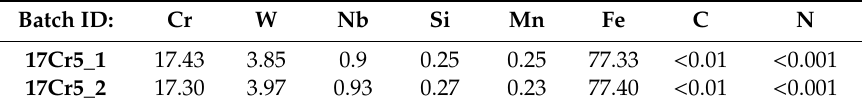
Table 1. Chemical compositions of the trial alloys (wt. %)